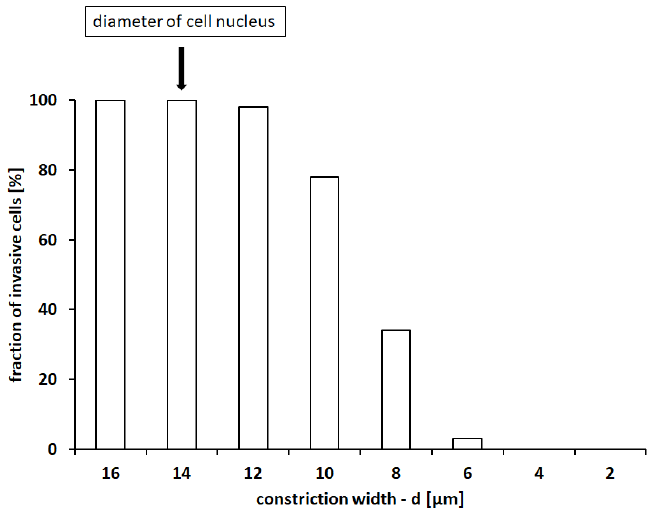
Figure 2. Percentage of invasive cells (i.e., of cells able to touch the upper border of the domain) in the case of reproduction of the device developed in [19]. Values were calculated over 100 numeri- cal